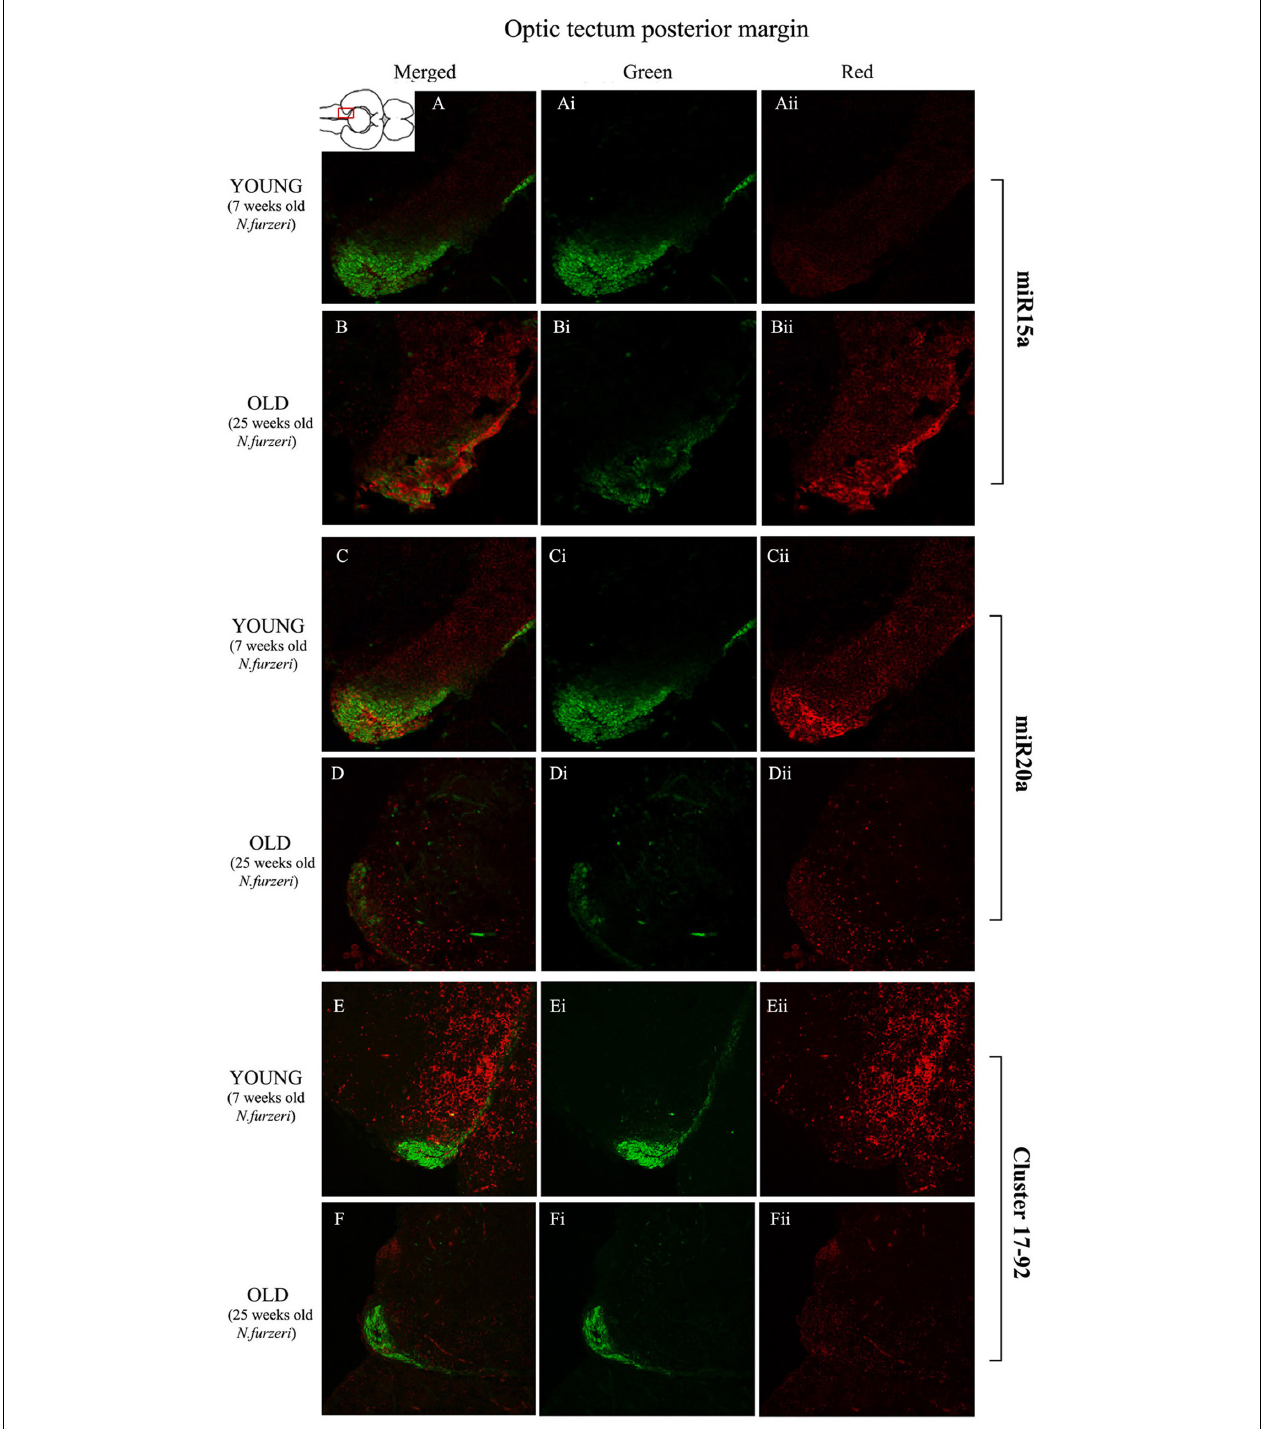
FIGURE 6 | Magnification of the posterior margin of the optic tectum (pOT) stained in green for PCNA by IHC, and in red for miR15 (A,B strips), miR20 (C,D strips) and Cluster17–92 (E,F strips) by ISH. The upper inset on A shows an overview of a horizontal brain section: the location of the pOT is indicated by the red rectangle. The left column of the panel ( A – F ) shows the merged channels for the double staining; A,B refer